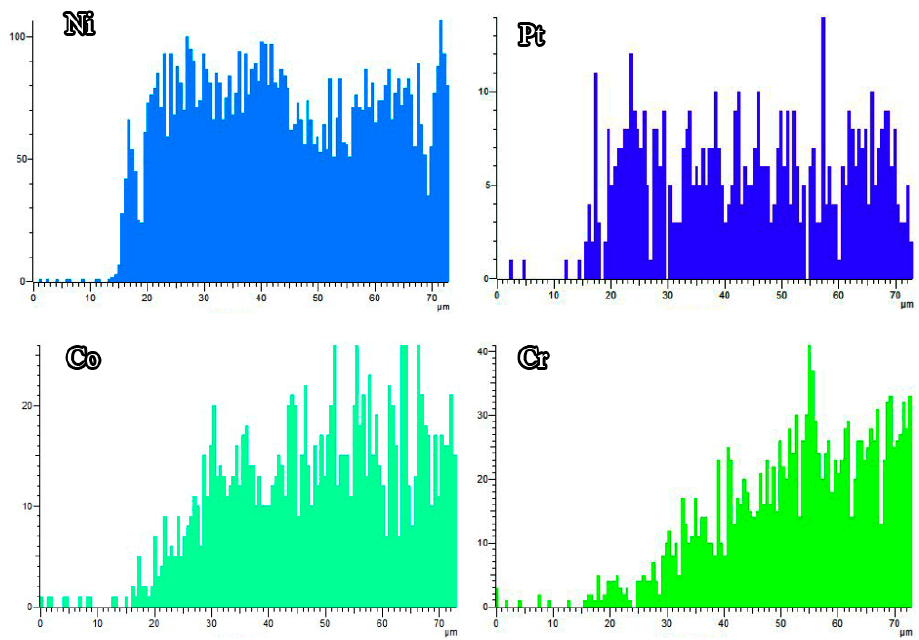
Figure 9. The line scanning image of the PtSiAl coating from outside to the inner layer by SEM.